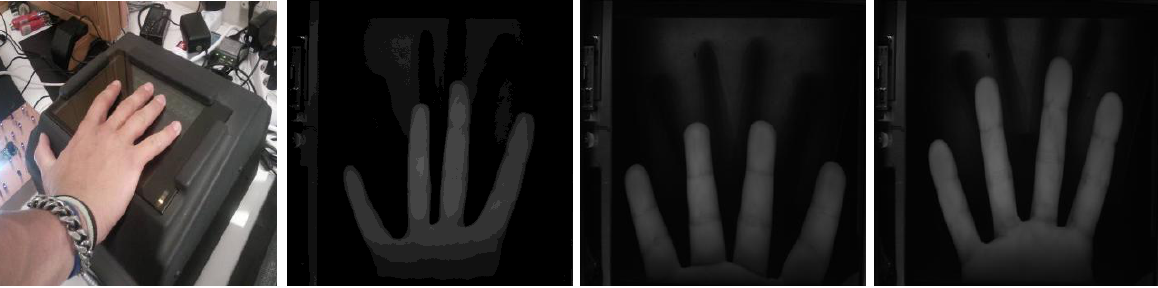
Figure 5. PRM acquisition device (figure on the left) and acquired IR hand images from three different users (three figures on the